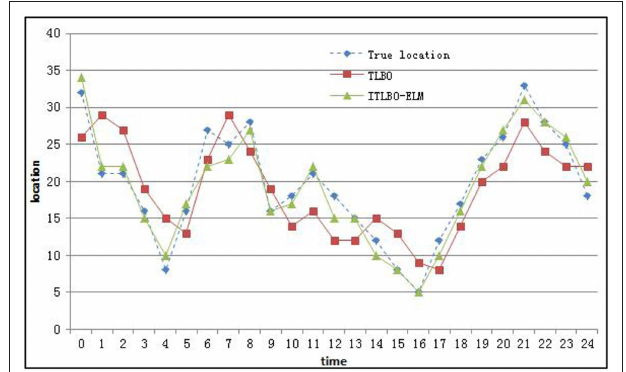
FIGURE 2 | Comparison of prediction effect of 1-day